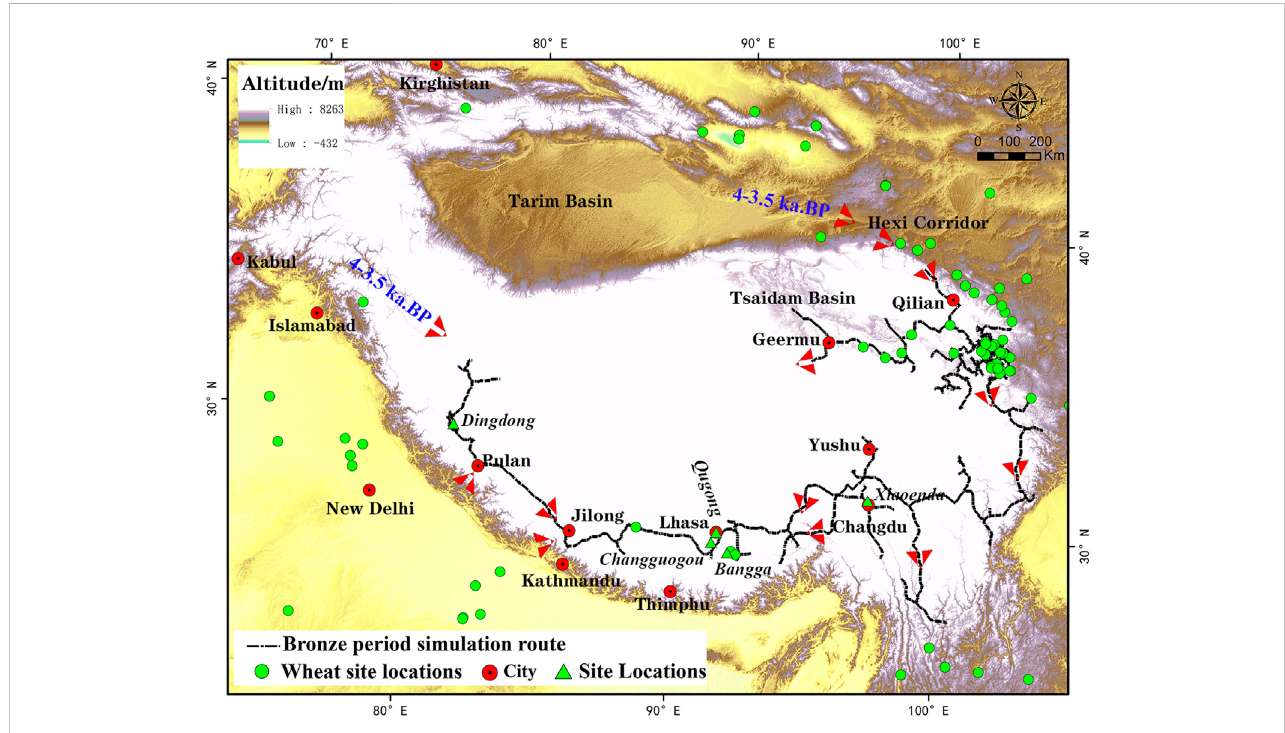
FIGURE 6 Simulatedexchangeroutes comparedwitharchaeologicalevidenceforthespreadofwheatagricultureintheBronzeAge,4 – 3.5ka.BP.Redarrowsmark the direction of movement. Point data of site locations are from Dong et al. (2022a), Dong et al. (2022b).